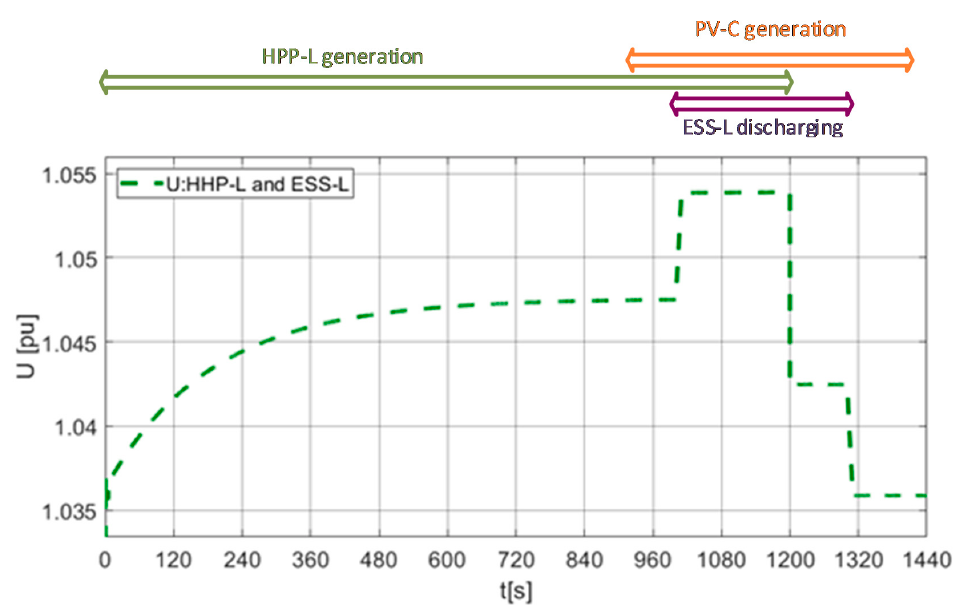
Figure 8. Voltage changes U in the connection point of the hydropower plant HPP- L and battery energy storage system ESS-L during the series of switching operations of HPP-L , PV-C and ESS-L .